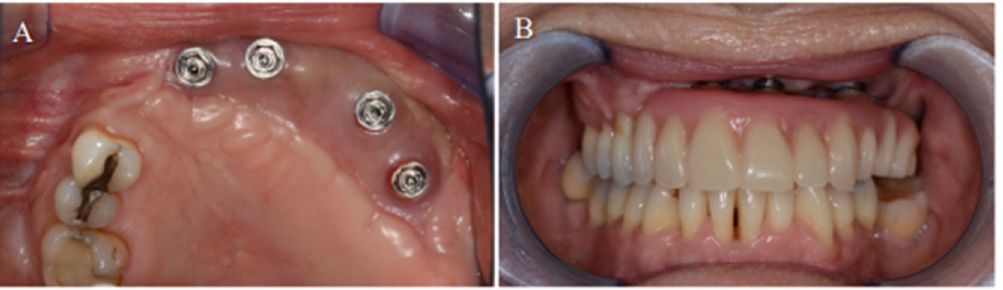
of the final acrylic dental